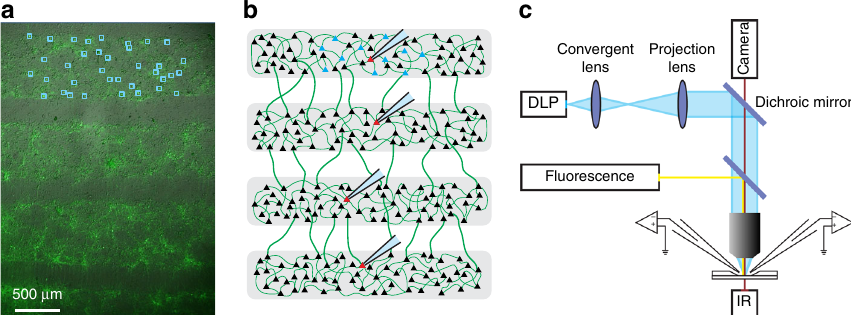
Fig. 1 Stimulation of neurons in cultured multilayer networks. a Neurons, visualized with IR-DIC and fl uorescent microscopy, are grown in distinct layers (0.7 × 6 mm 2 ) separated by 0.4 mm. b Schematic of the multilayer network. Cell-attached or whole-cell recordings could be performed from four neurons in sequential layers. c Using a Digital Light Processing (DLP) projector mounted on a microscope, brief light pulses (blue boxes in a ) were delivered to neurons (in layer 1) that expressed ChR2 and a fl uorescent tag